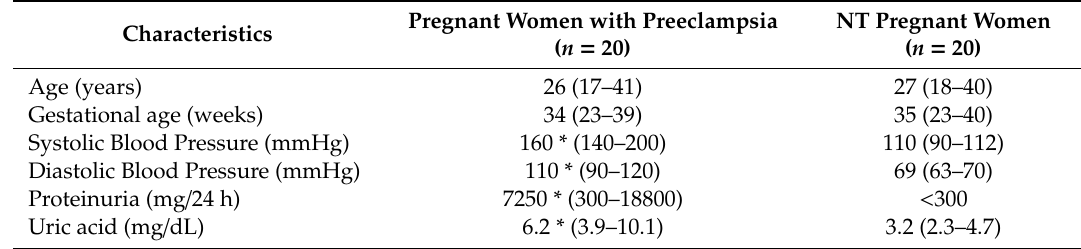
Table 1. Clinical and laboratory characteristics of preeclamptic and NT pregnant women.